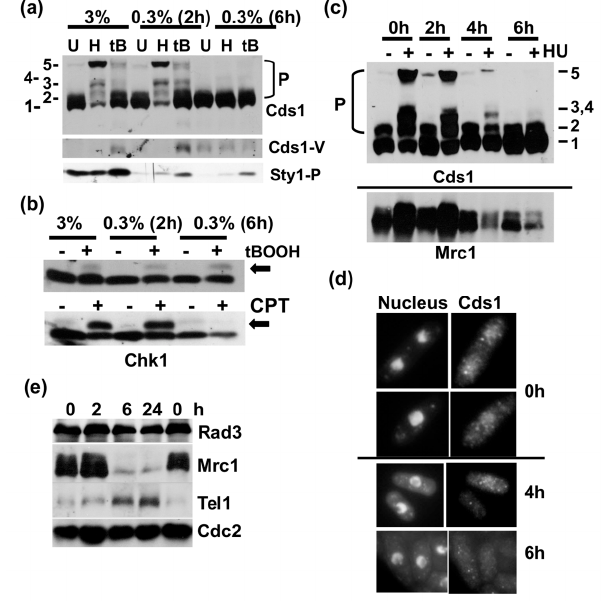
Figure 2. Low glucose concentrations terminate DNA replication. ( a ) Phos-tag SDS page of total protein extracts of Cds1-HA 2 His 6 (U = untreated, H = 12 mM hydroxyurea (HU) for 3.5 h, tB = 0.5 mM t-butylhydroxyperoxide 3.5 h). HU and tB were added to growing cells (3%) at 2 h or 6 h post-shift to 0.3% glucose. Cds1-V = N-terminally truncated Cds1 variant, Sty1-P = dual T171 + Y173 phosphorylation. ( b ) SDS page of total protein extracts of Chk1-HA 3 ; 0.5 mM tB and 12 μ M camptothecin CPT were added at the indicated times and cells were incubated for another 2 h (arrow = Chk1-S345-P shift band). ( c ) Repeat experiment of ( a ). ( d ) Indirect immunofluorescence images of Cds1-Myc 13 0 h, 4 h and 6 h post-shift to 0.3% glucose (nucleus = DAPI, Cds1 = antibody signal). ( e ) SDS page of total protein extracts 0 h, 2 h, 6 h and 24 h post-shift to 0.3% glucose (Myc-Rad3,